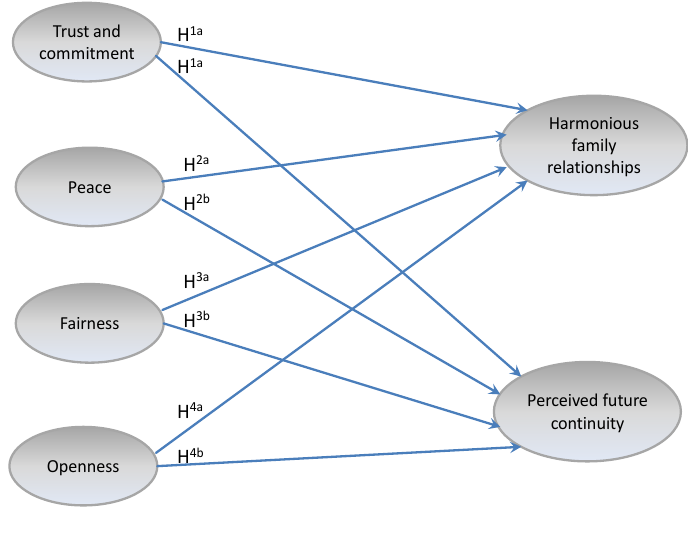
Figure 2: The modified hypothesised